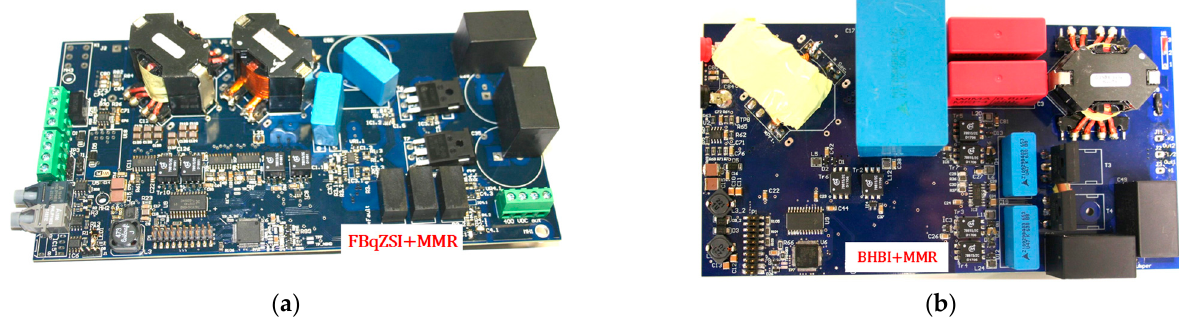
Figure 7. Experimental prototypes of the high step-up DC-DC converters utilizing the MMR along with ( a ) FBqZSI and ( b ) BHBI. Table 4. Specifications of the experimental